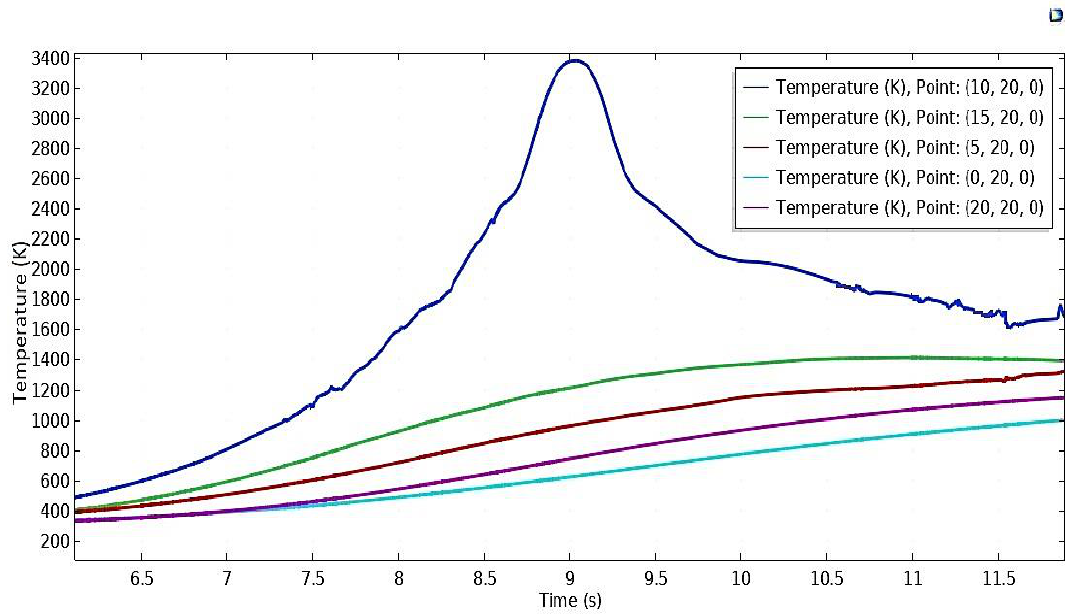
Figure 11. Temperature distribution of temperature probes of two different domains having the same Y = 20 mm.